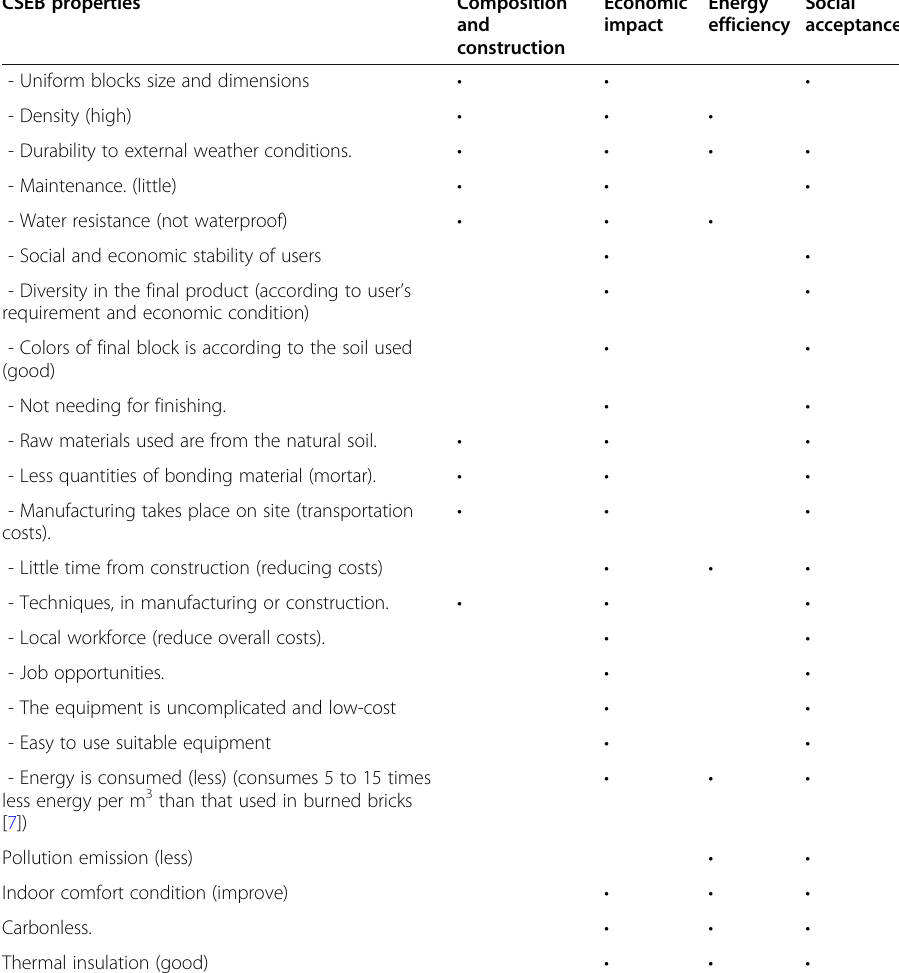
Table 2 The advantages and disadvantages of using CSEB in construction [21 –